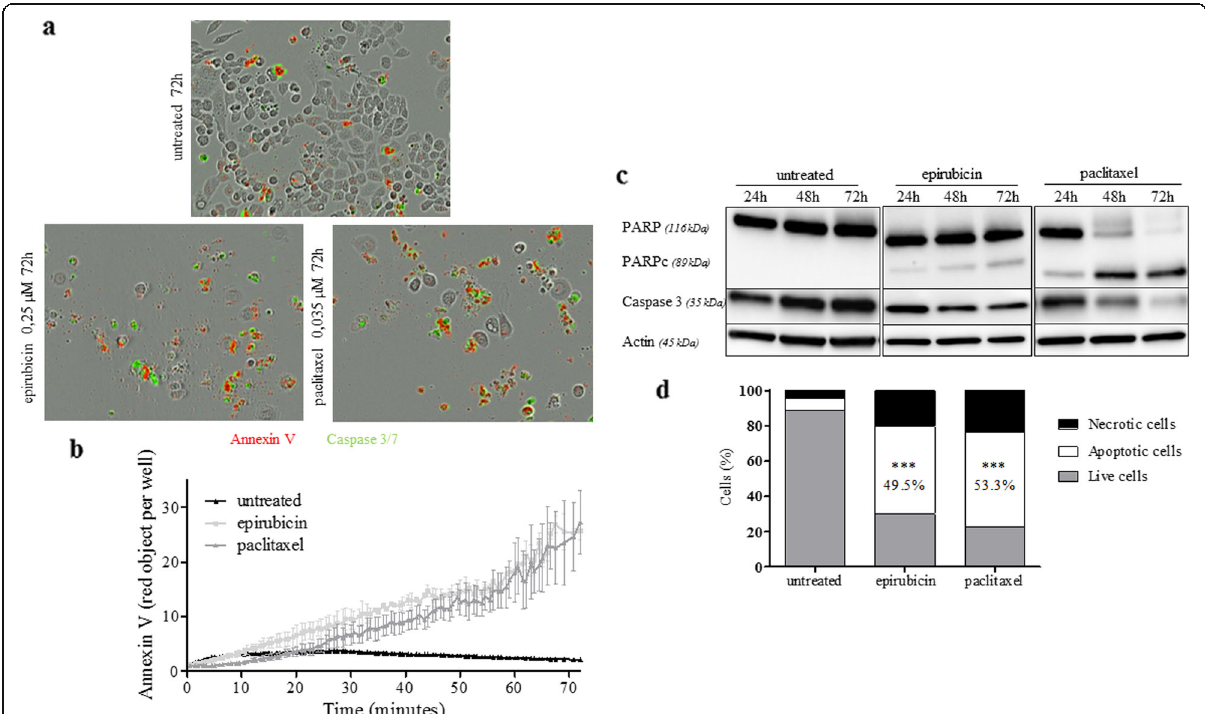
Fig. 3 Apoptotic induction after treatment by paclitaxel or epirubicin in MDA-MB-468 cells. a Time-lapse images detection of apoptosis in MDA-MB- 468 cells in the presence of Caspase-3/7 Green Apoptosis reagent and Annexin V Red Reagent. b Percent of apoptotic cells with high annexin V reagent was assessed in time-lapse imaging (IncuCyte) over 72 h. c Western blot analysis showing the cleavage of PARP and Caspase 3. Actin was used as a loading control. d Quantitative analysis of apoptotic cells measured by flow cytometry in untreated, epirubicin-treated, or paclitaxel-treated MDA-MB-468 cells for 72 h. ( n = 3 independent experiments; mean ± SD). Compared to untreated, *** p < 0.001 (Mann-Whitney